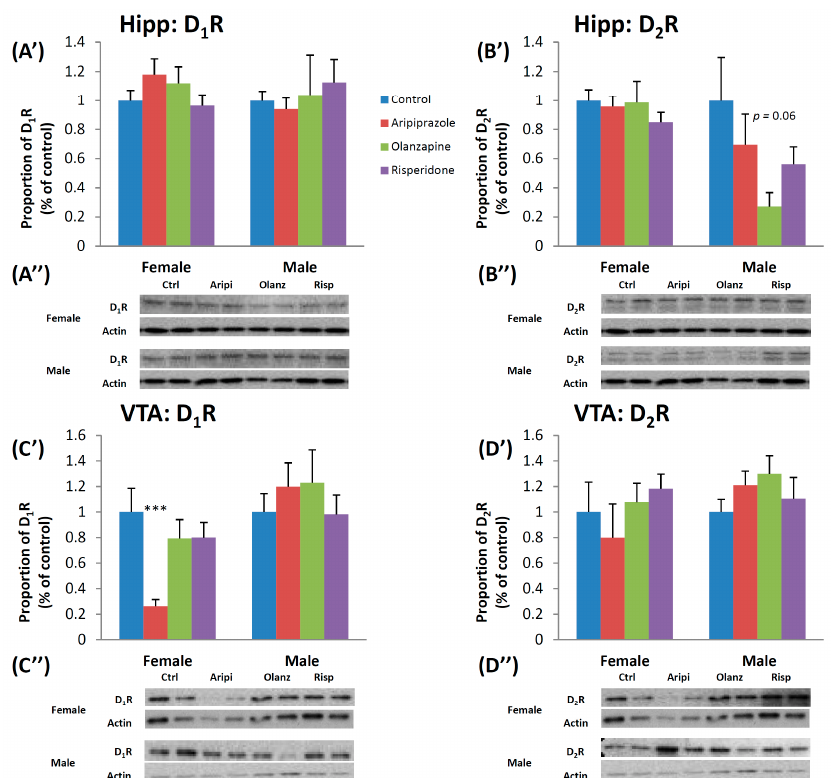
Figure 3. Effects of three APDs on D 1 and D 2 receptor expression levels in the Hippocampus (D 1 R: ( A’ , A” ); D 2 R: ( B’ , B” )) and VTA (D 1 : ( C’ , C” ); D 2 : ( D’ , D” )) of female and male rats. Sprague-Dawley rats were treated chronically with Aripiprazole (1.0 mg/kg, t.i.d), Olanzapine (1.0 mg/kg, t.i.d), Risperidone (0.3 mg/kg, t.i.d) or control (vehicle). Data expressed as mean ± SEM. *** p < 0.001 vs. control. The representative bands of Western blot are shown. APD: Antipsychotic drug; Hipp: Hippocampus; t.i.d.: Three times daily; VTA: Ventral Tegmental Area.